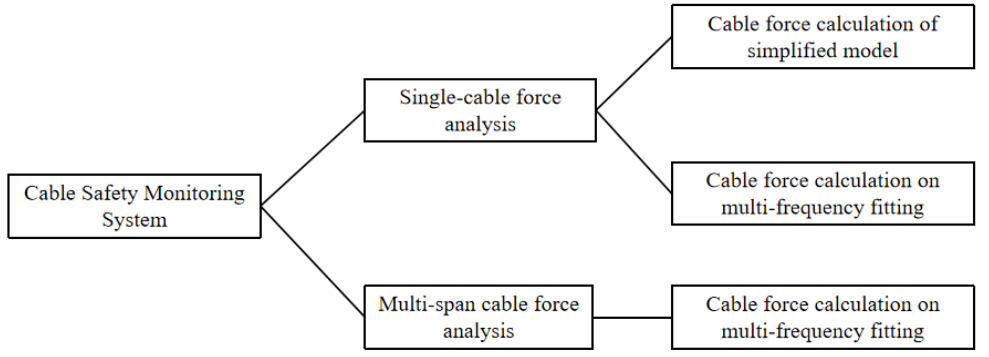
Figure 19. Software structure organization.